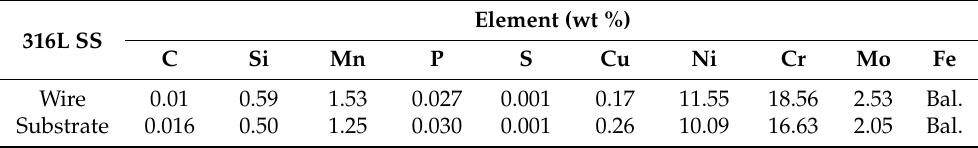
Figure 1. ( a ) Schematic diagram of the experimental setup and ( b ) shape of the deposit. Table 1. Chemical compositions of the 316L SS wire and substrate.